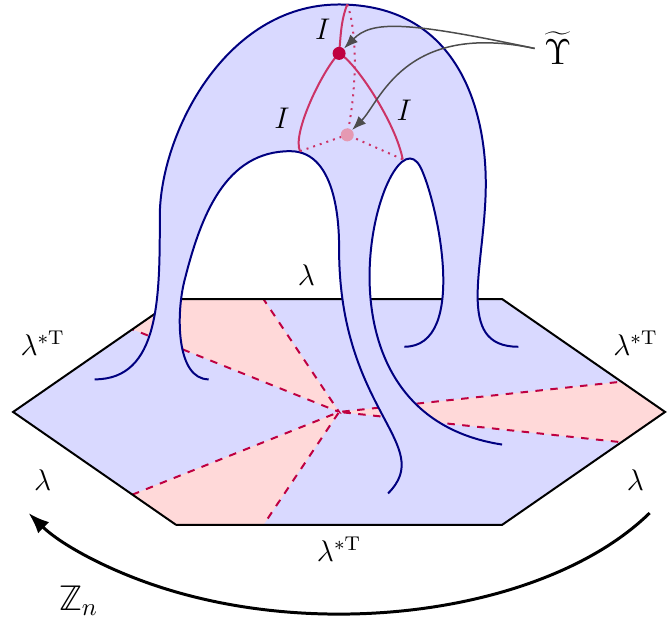
= Z [ λ, . . . , λ ] has a Z n replica symmetry. In ( n ) ( n )